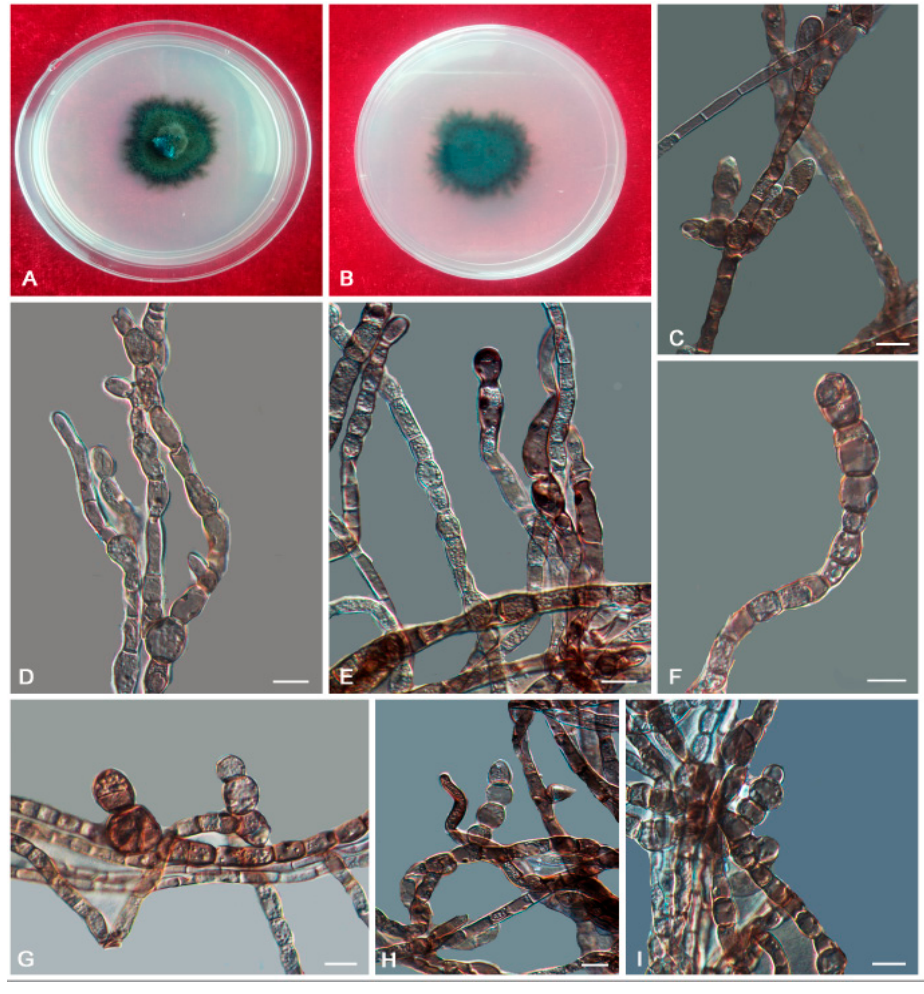
Figure 14. Trichomerium flexuosum (CGMCC 3.17988). ( A , B ) Colony forward and reverse after 20 weeks on MEA. ( C , D ) Hyphae with septa constricted. ( E , F ) Apical swollen cell. ( G – I ) Moniliform hyphae with blastic proliferation of the branches. Scale bars: ( C – I ) = 10 µ